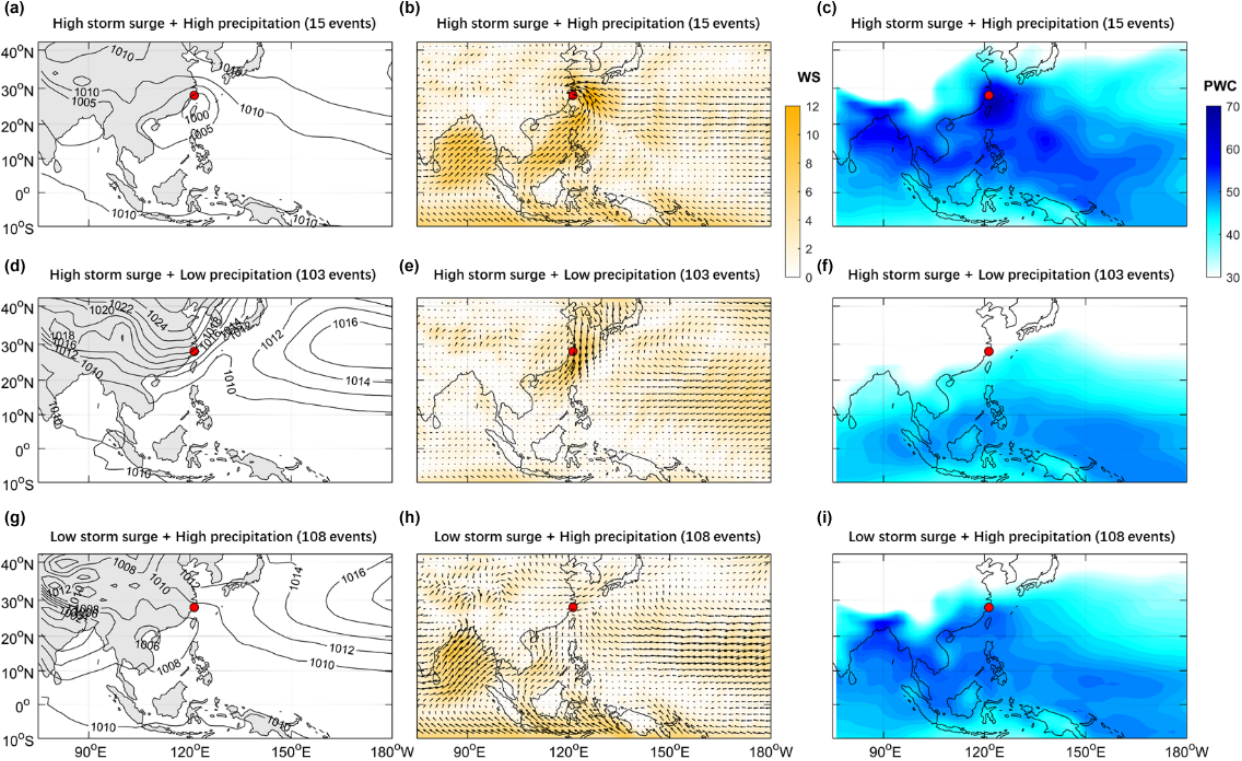
Figure 7. Meteorology conditions for Kanmen (TG4): (a, d, g) sea-level pressure (mbar), (b, e, h) wind speed (ms − 1 ) and direction (grey arrows), and (c, f, i) precipitable water content (PWC, kgm − 2 ) during (a–c) joint occurrence events with high storm surge and high pre- cipitation (Zone 1), (d–f) for events with high storm surge and low precipitation (Zone 3), and (g–i) events with low storm surge and high precipitation (Zone